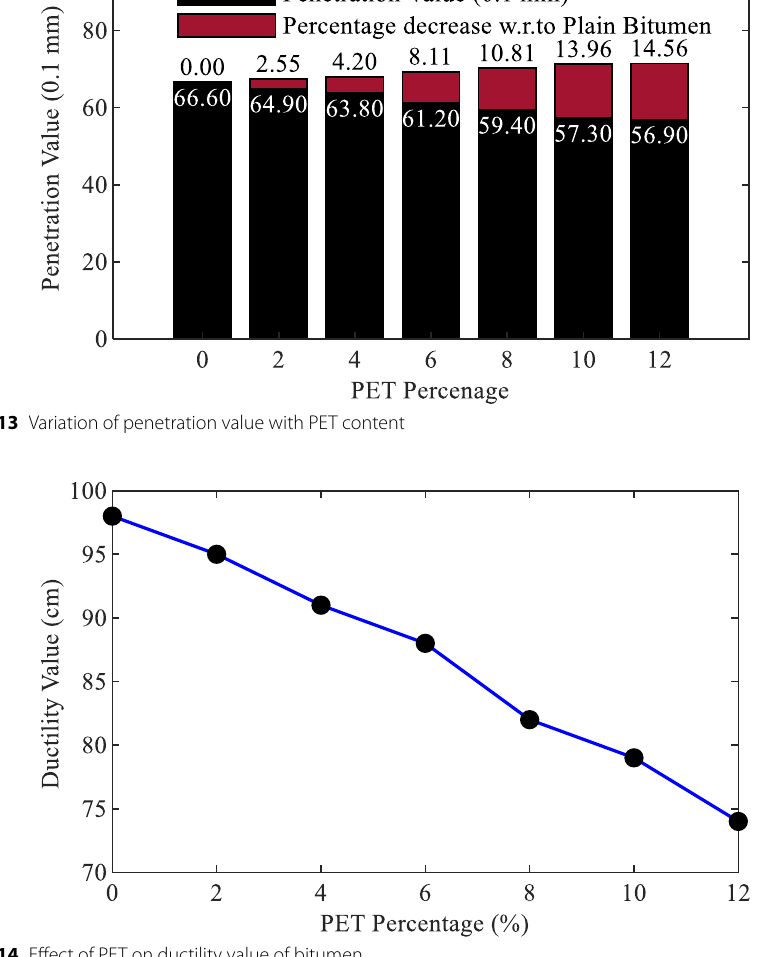
Fig. 14 Effect of PET on ductility value of